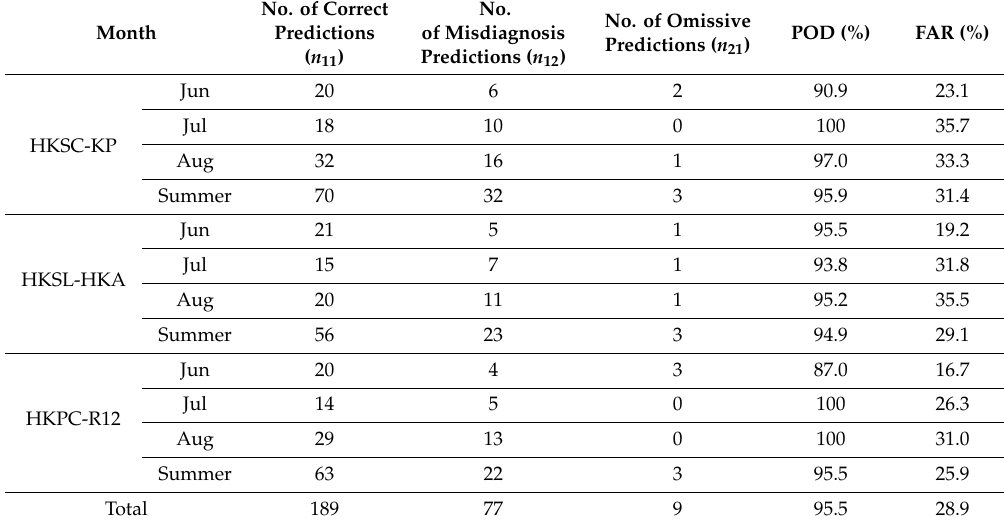
Table 9. Predictions of each summer month in 2018 and 2019 at the three stations resulting from the new model.